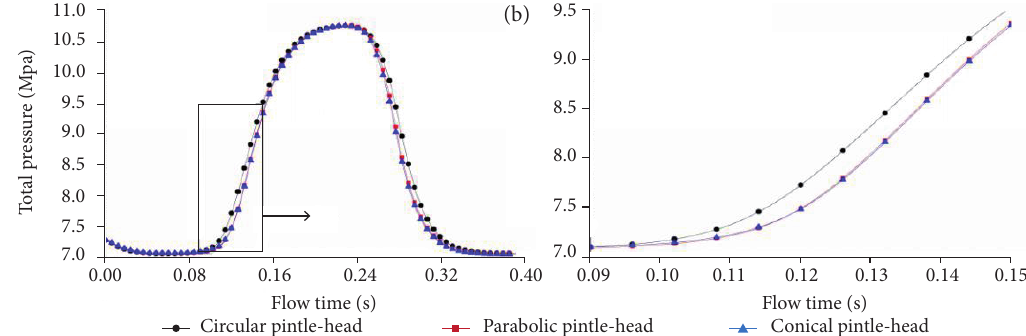
Figure 5. Total pressure simulation data of three pintle head models.